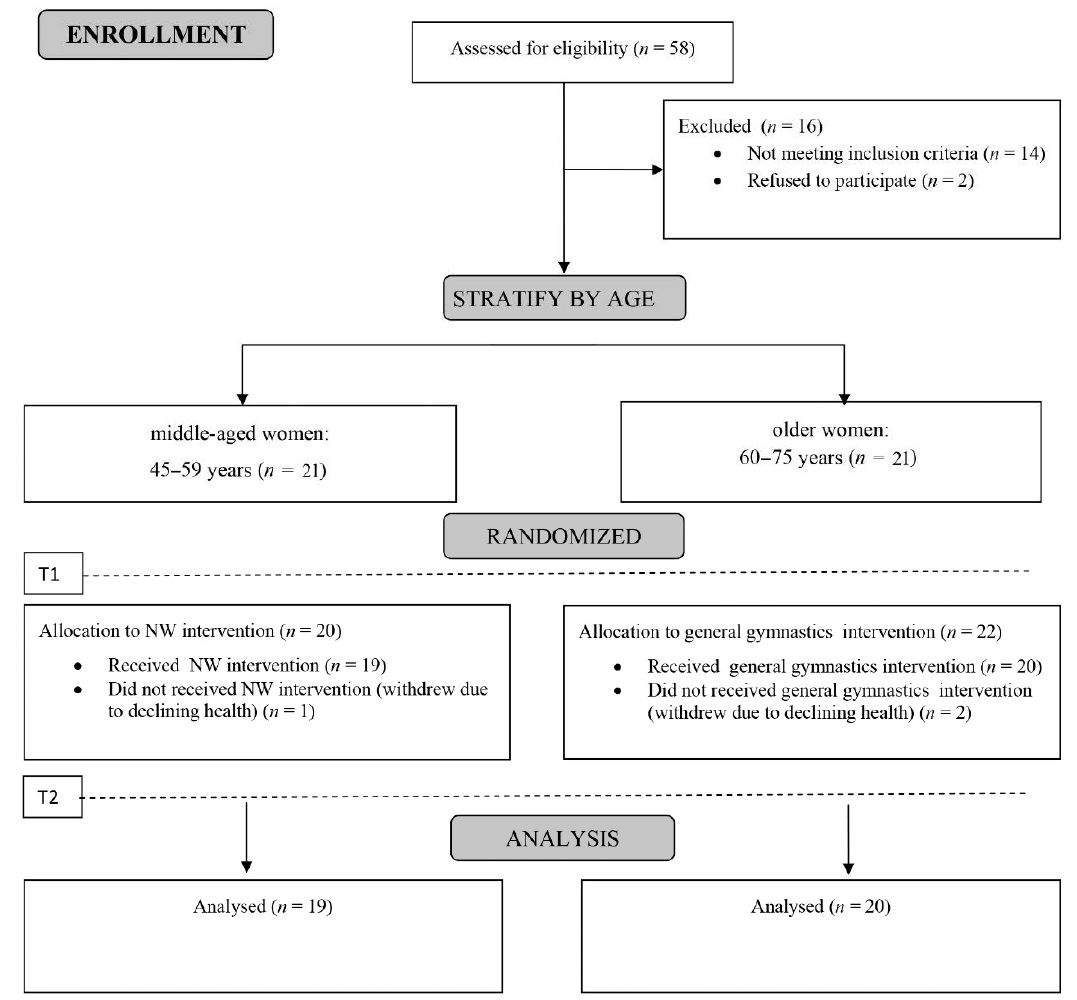
Figure 1. The participants flow diagram. Abbreviations T1: pre– and T2: post–training assessment of the sagittal spinal curvature parameters and isokinetic trunk muscle endurance.